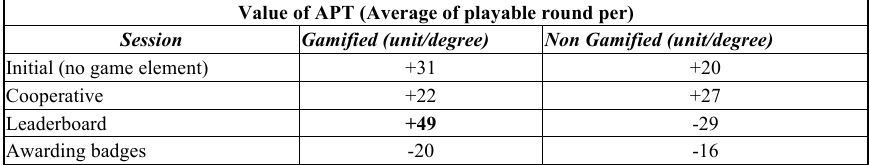
Table 2. Angle changes of APT for each game